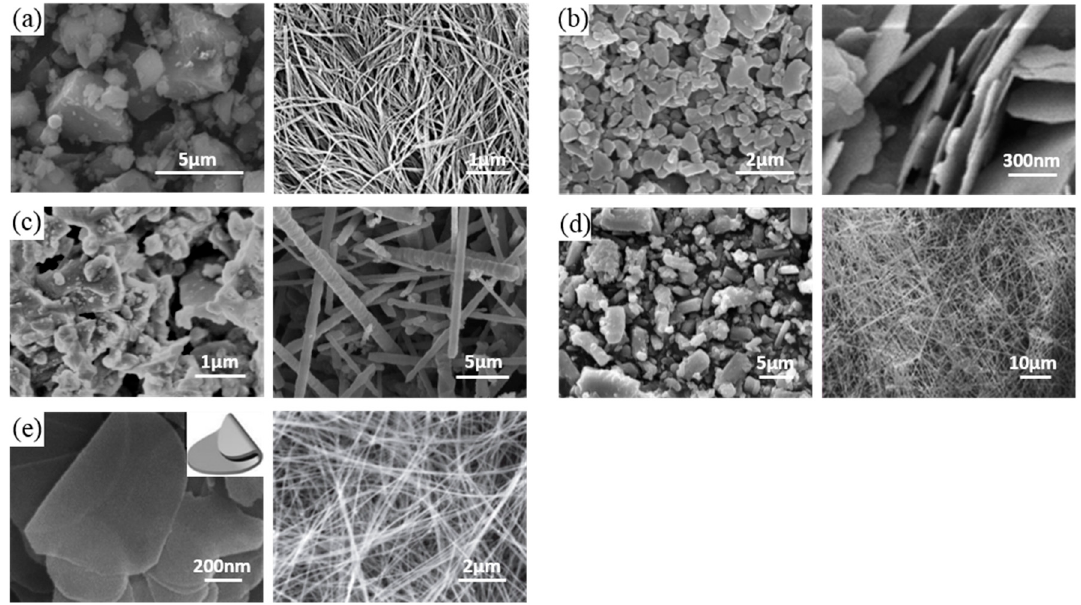
Figure 1. Examples of several high thermal conductive nanoscale ceramic fillers. ( a ) Aluminum nitride